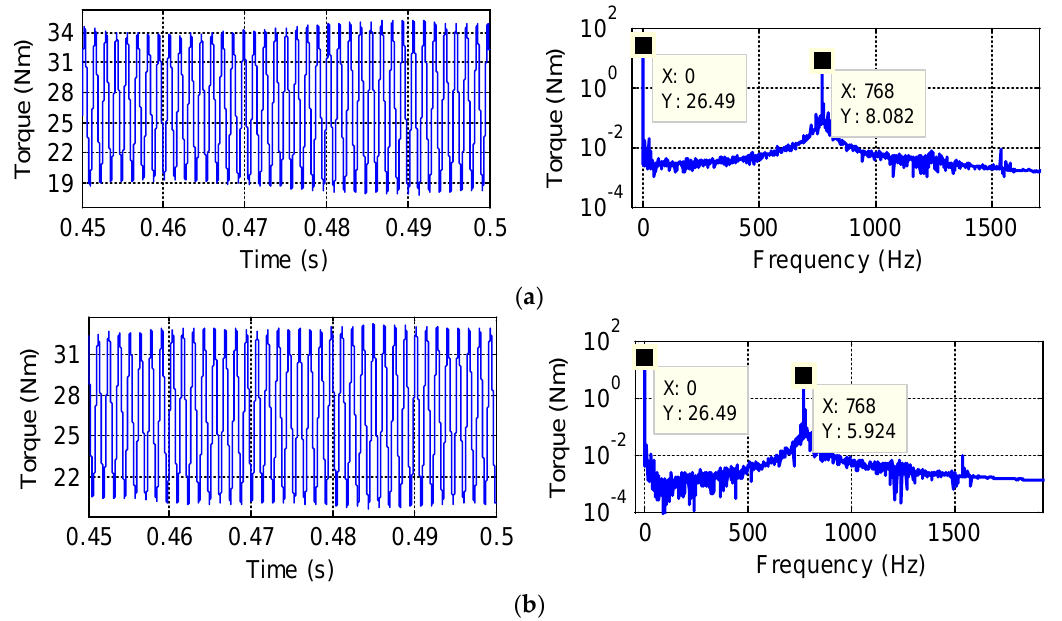
Figure 25. Torque response of middle shaft of the reducer at motor speed of 1920 rpm: ( a ) Before suppression; ( b ) After suppression.